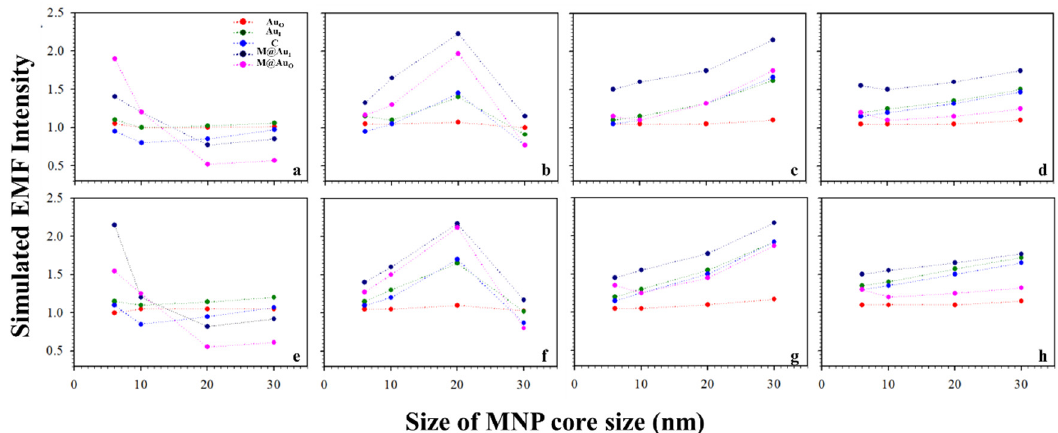
Figure 5. Plots of the simulated EMF intensity for the dimer of “Ab1/Au 60 nm –CEA ( a – d ) or NSE ( e – h )–Ab2/M@Au” vs. different sizes of Fe 3 O 4 core at different locations of Au O , Au I , C, M@Au I , and M@Au O . Different Fe 3 O 4 –Au shell thicknesses of 1 ( a , e ), 3 ( b , f ), 5 ( c , g ), and 10 nm ( d , h ).